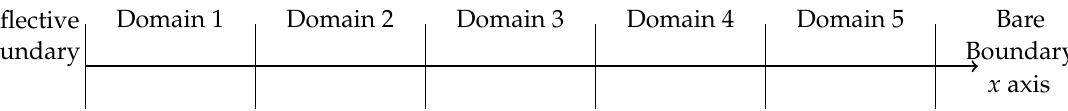
Figure 1. Geometry of how a 1D slab reactor may be split into five domains with a reflective boundary condition on the left-hand side and a bare boundary condition on the right-hand side.